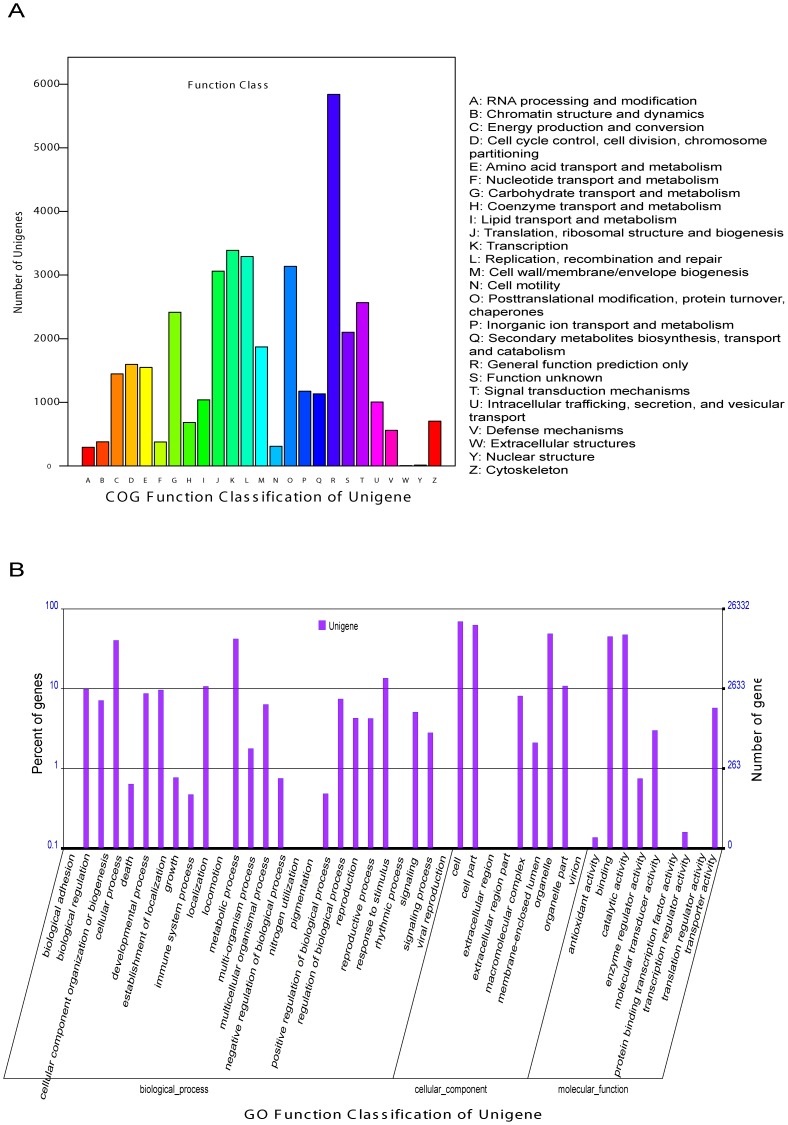
COG and GO classification of the safflower flower tissue transcriptome.(A) COG functional classification of the transcriptome. A total of 21,943 unigenes showed significant homologies to genes in the COG Nr database (E-value <1.0−5), distributing to 25 COG categories. (B) GO classification of the safflower flower tissue transcriptome. A total of 26,332 safflower unigenes were assigned to 1,754 GO term annotations using BLAST2GO, and then summarized into the three main GO categories and 44 sub-categories (functional groups).